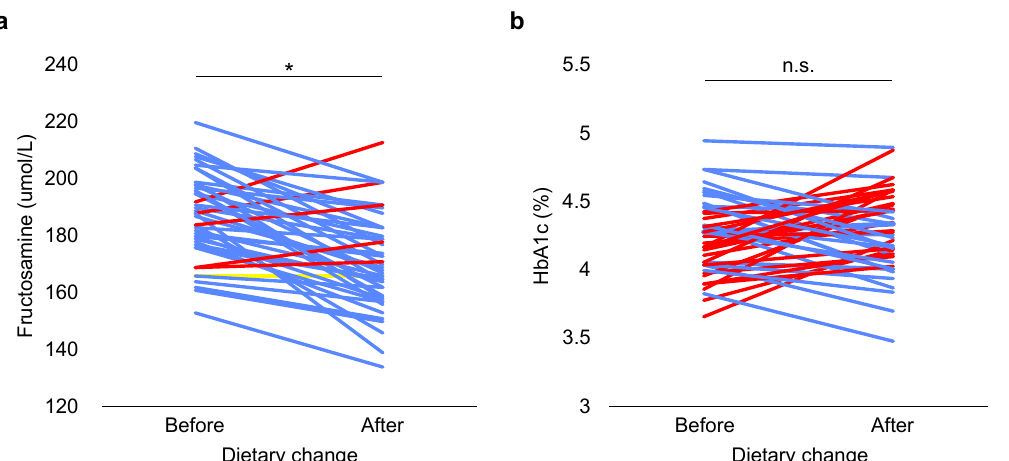
Figure 3. Effect of dietary change on fructosamine ( a ) and HbA1c levels ( b ) in adult female long-tailed macaques. Each line represents an individual ( n = 44). Blue lines represent a decrease, while red lines indicate an increase and yellow lines represent no change. * means statistically significant difference, p < 0.05; n.s. means non-significant ( p ≥ 0.05).